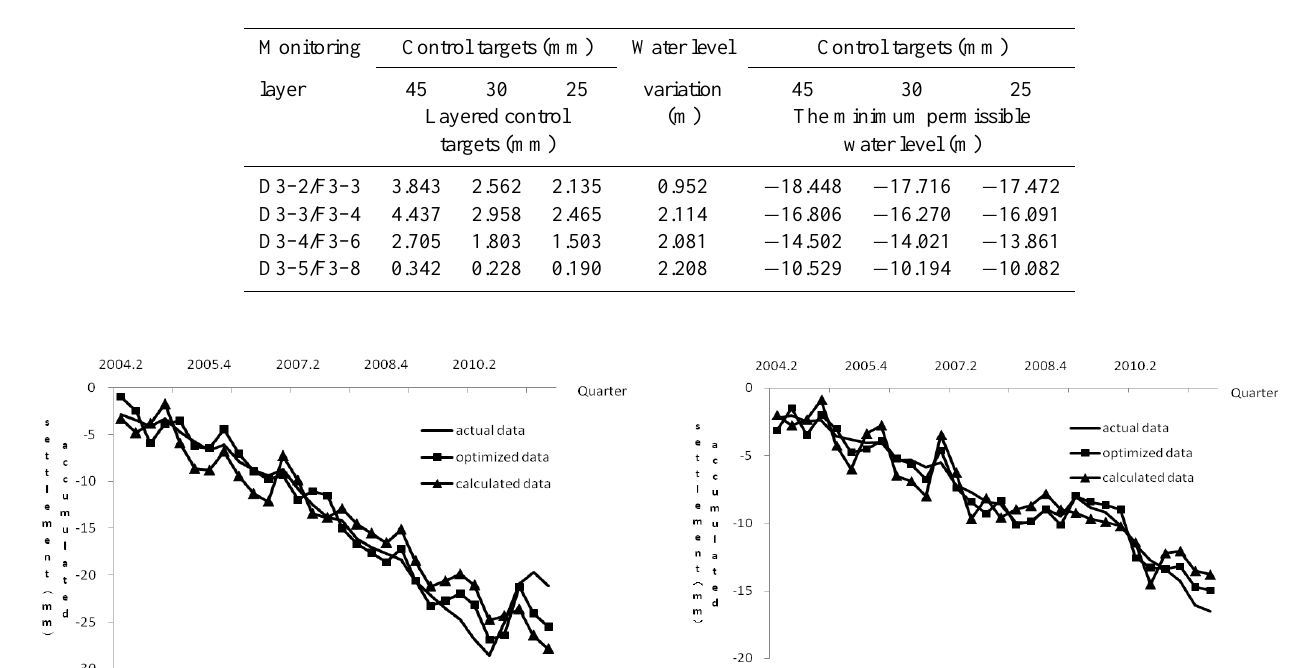
Table 3. The minimum permissible level of groundwater in different control of settlement velocity.